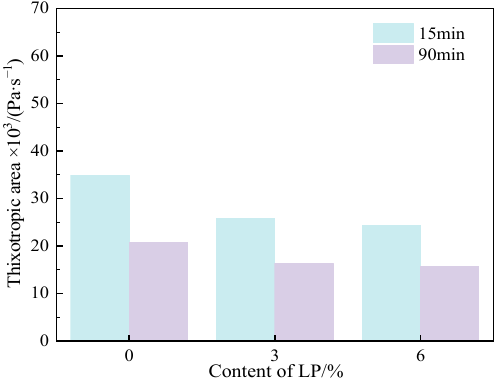
Figure 6. Thixotropic area of C-LP pastes.